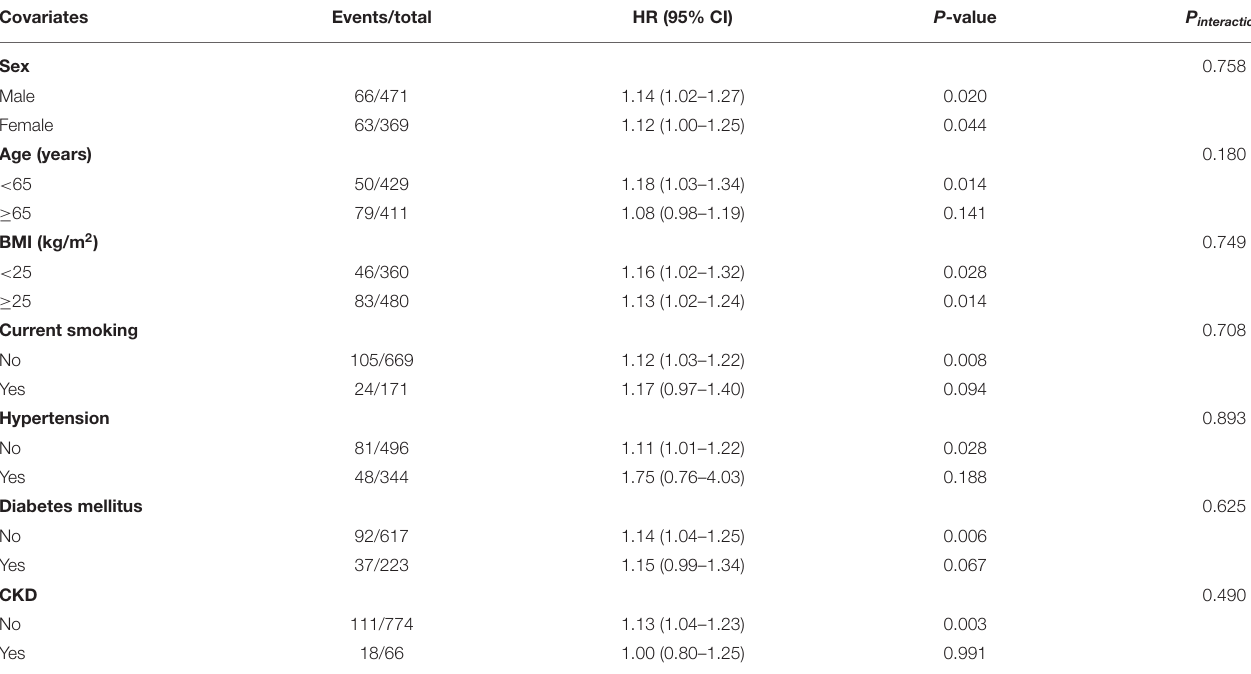
TABLE 4 | Subgroup analyses for the association between circulating RBP4 concentration and MACEs.